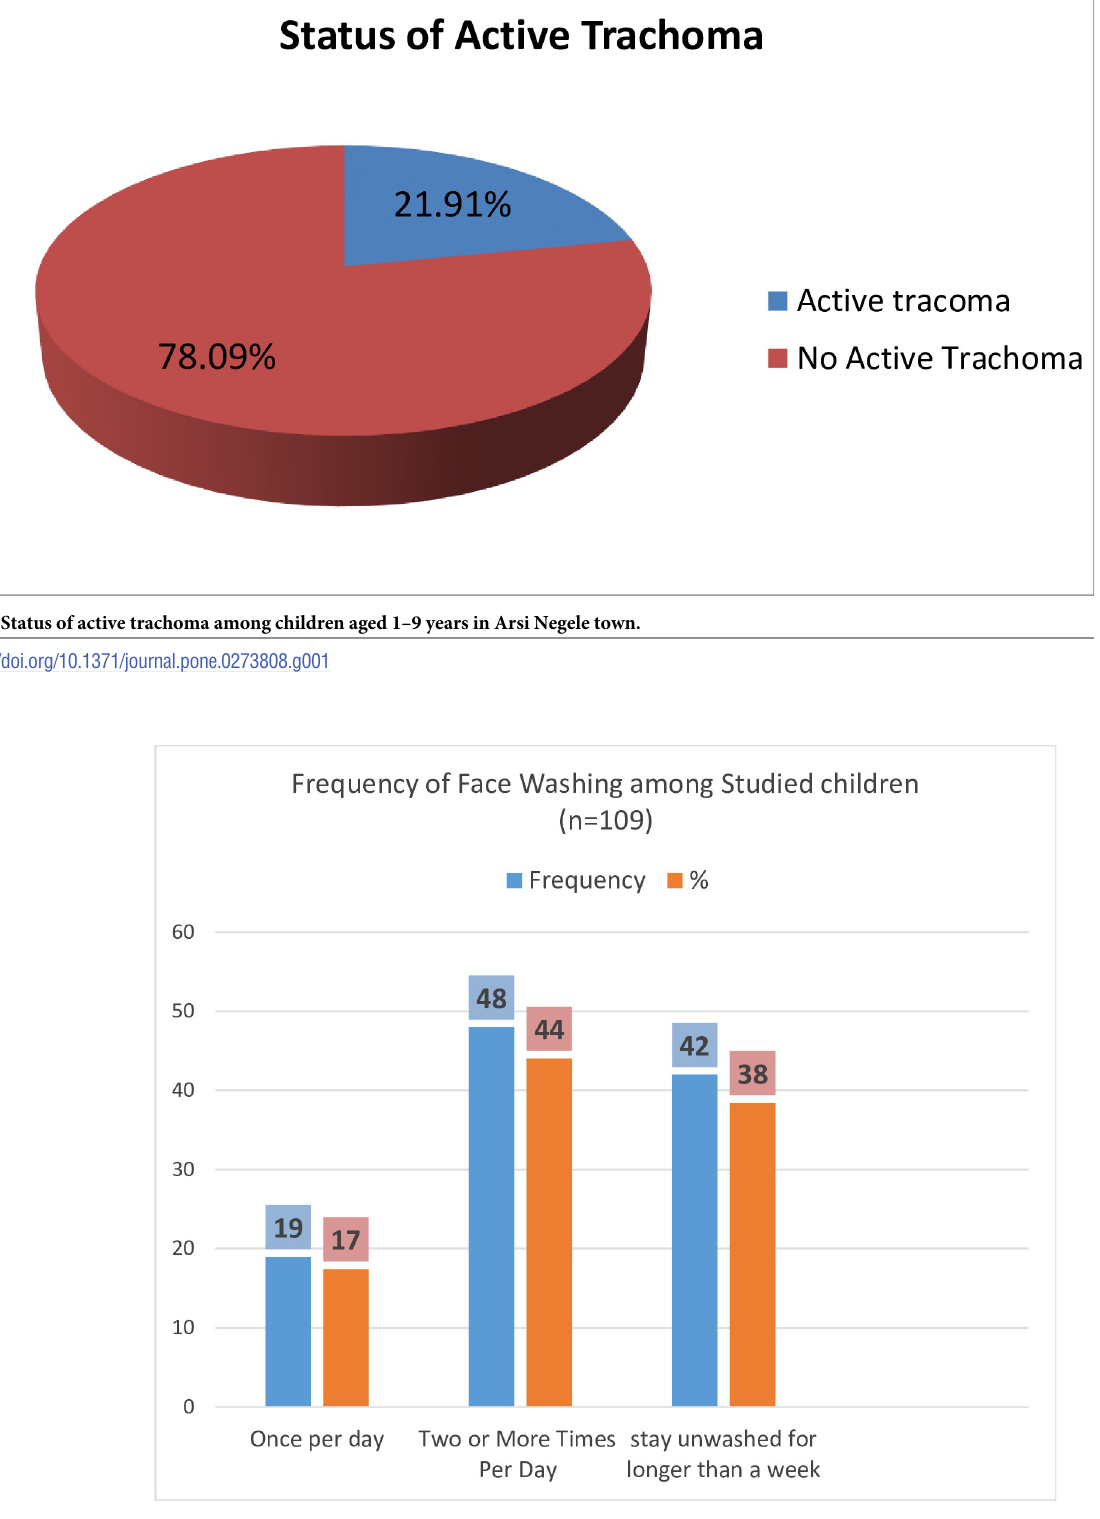
PLOS ONE | https://doi.org/10.1371/journal.pone.0273808 October 7, 2022 11 /